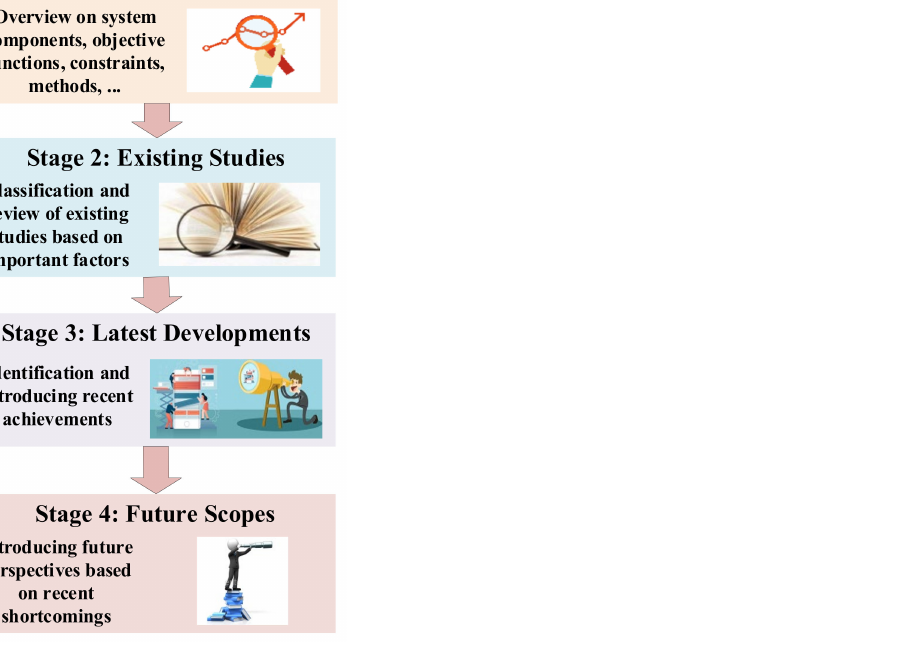
Figure 3. A general view of the technical roadmap of this review study on optimal planning of RAES